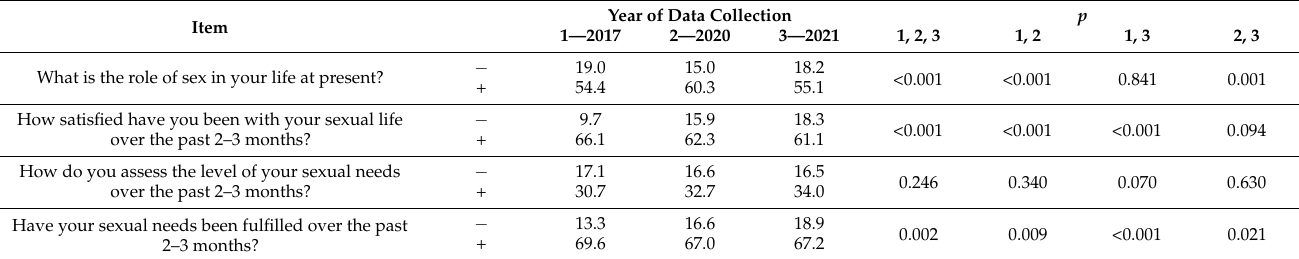
Table 2. Evaluation of own sexual life in the three study periods (% of positive and negative responses).